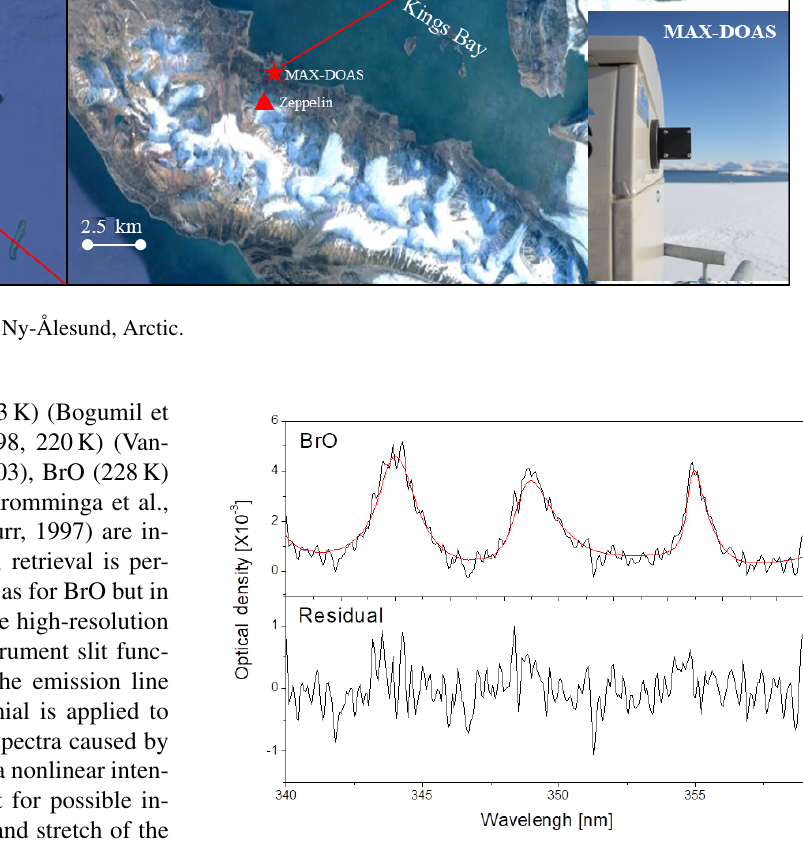
Figure 4. Examples of spectral retrieval of BrO. The spectrum was recorded under clear sky conditions at 2 ◦ elevation on 26 April 2015, 19:59UTC, SZA = 86 ◦ . (Black lines represent retrieved spec- tral signatures fitted result for absorber, and red lines represent fitted cross